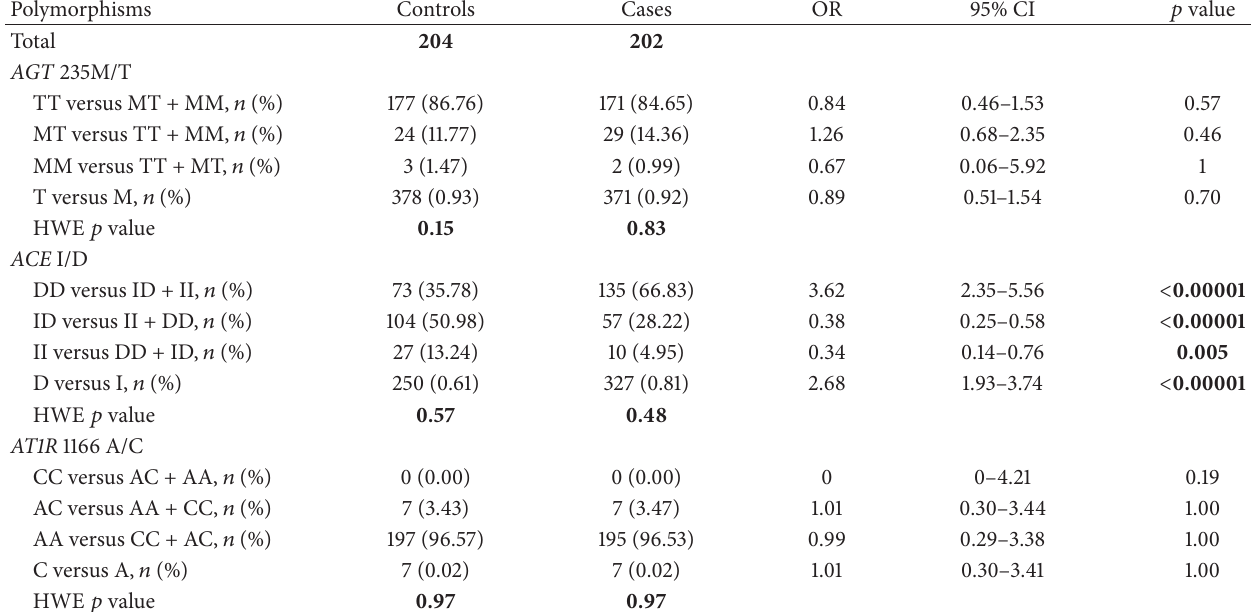
Table 2: Frequencies of renin-angiotensin system genes polymorphisms (cases versus